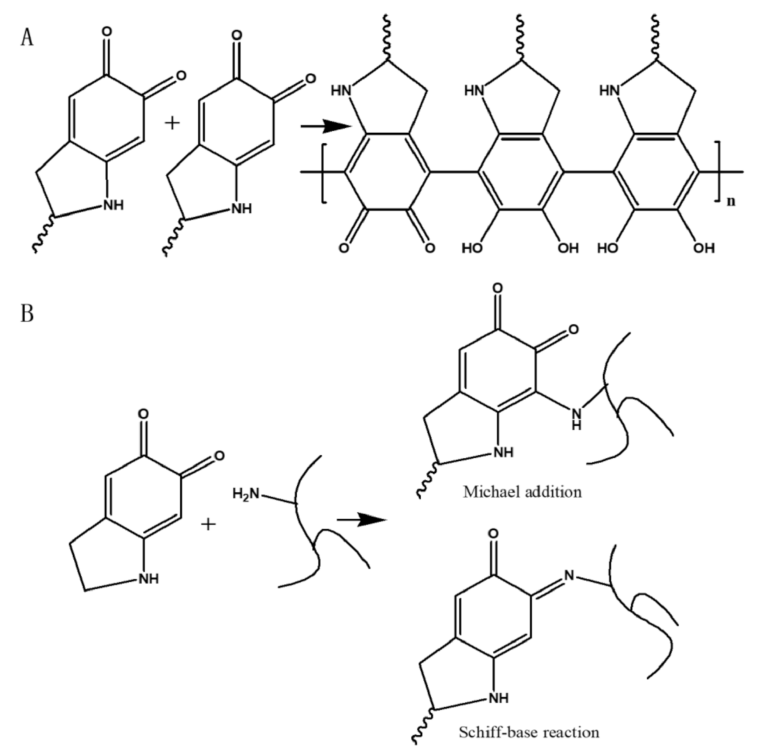
Figure 7. Reaction mechanisms between PDA and PEI: ( A ) self-polymerization of PDA, ( B ) Michael addition and Schiff base reaction of PDA and